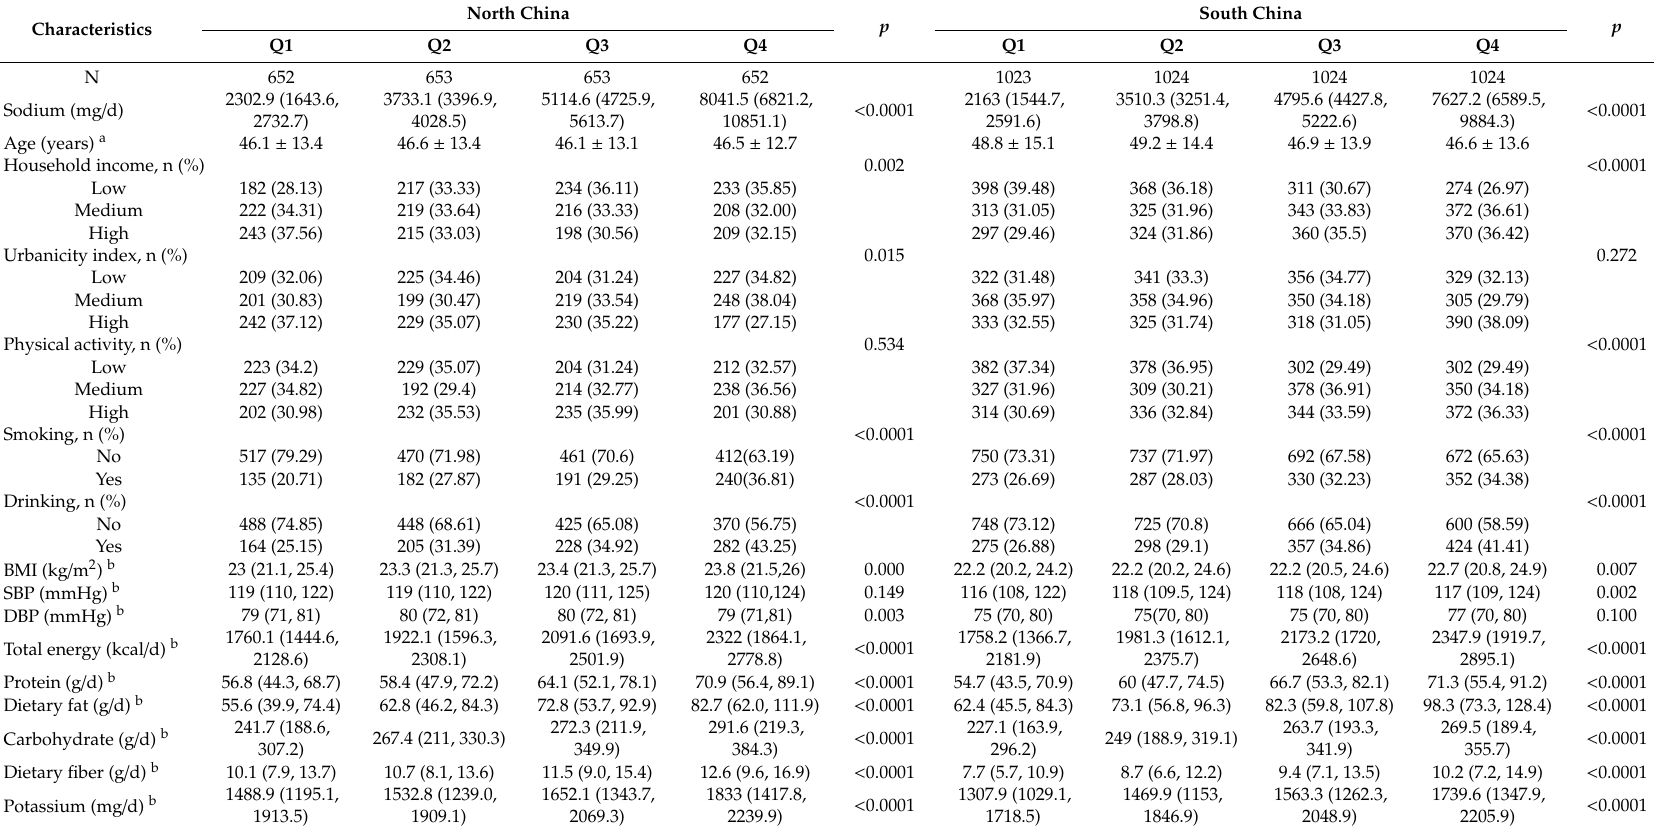
Table 1. Baseline characteristics of participants according to areas quartiles of dietary sodium